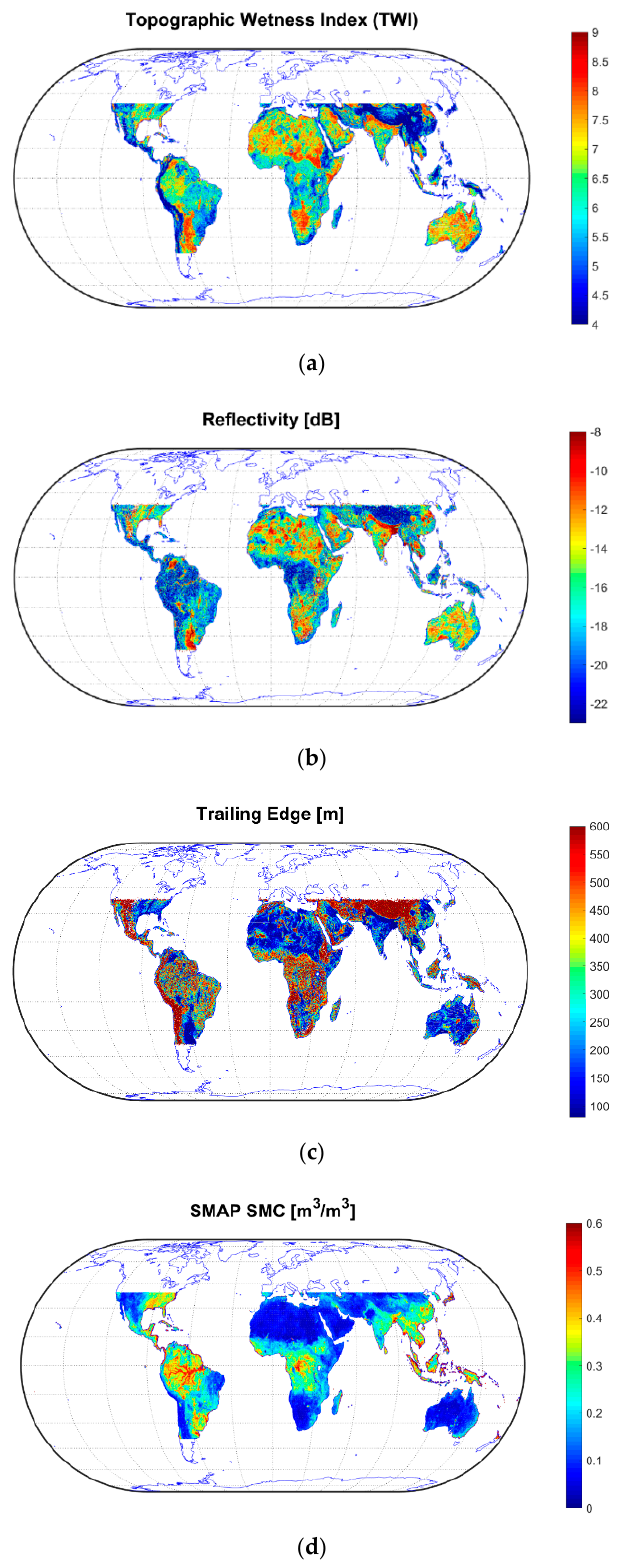
Figure 3. ( a ) TWI , ( b ) CyGNSS-derived Γ (dB), ( c ) CyGNSS-derived TE (m), and ( d ) Soil Figure 3. ( a ) TWI, ( b ) CyGNSS-derived Γ (dB), ( c ) CyGNSS-derived TE (m), and ( d ) Soil Moisture Moisture Active Passive (SMAP)-derived SMC (m 3 /m 3 ). CyGNSS and SMAP data correspond to a Active Passive (SMAP)-derived SMC (m 3 / m 3 ). CyGNSS and SMAP data correspond to a temporal window of six months (1 August 2018 to 31 January 2019). The parameters were displayed over the CyGNSS coverage over land